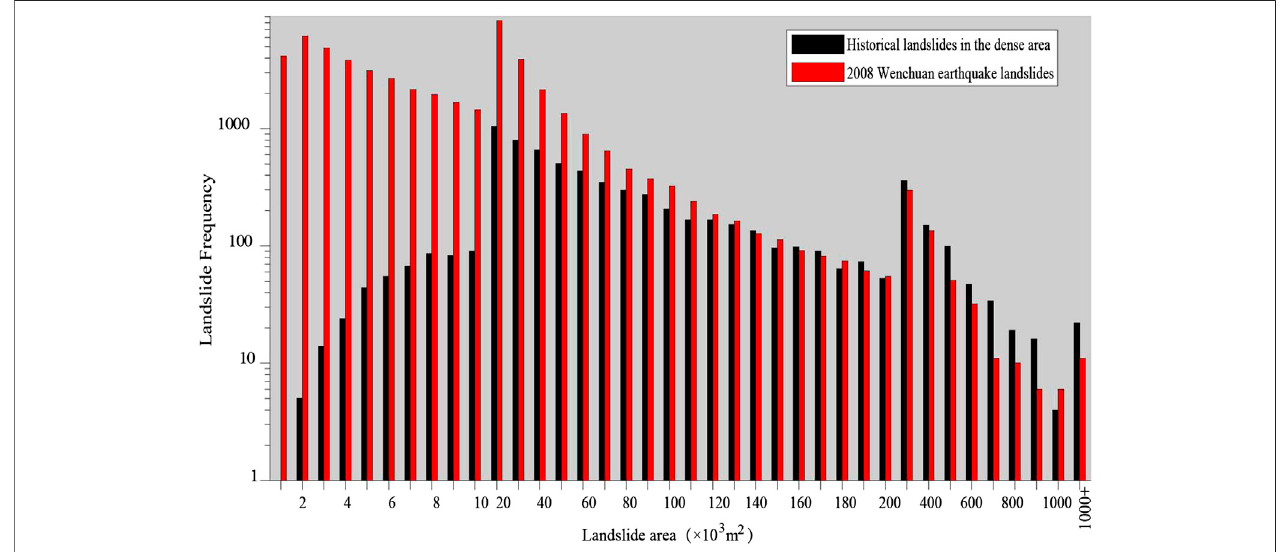
FIGURE 7 | Comparison of the area-frequency relationship between the Qishan earthquake landslide and Wenchuan earthquake landslide.